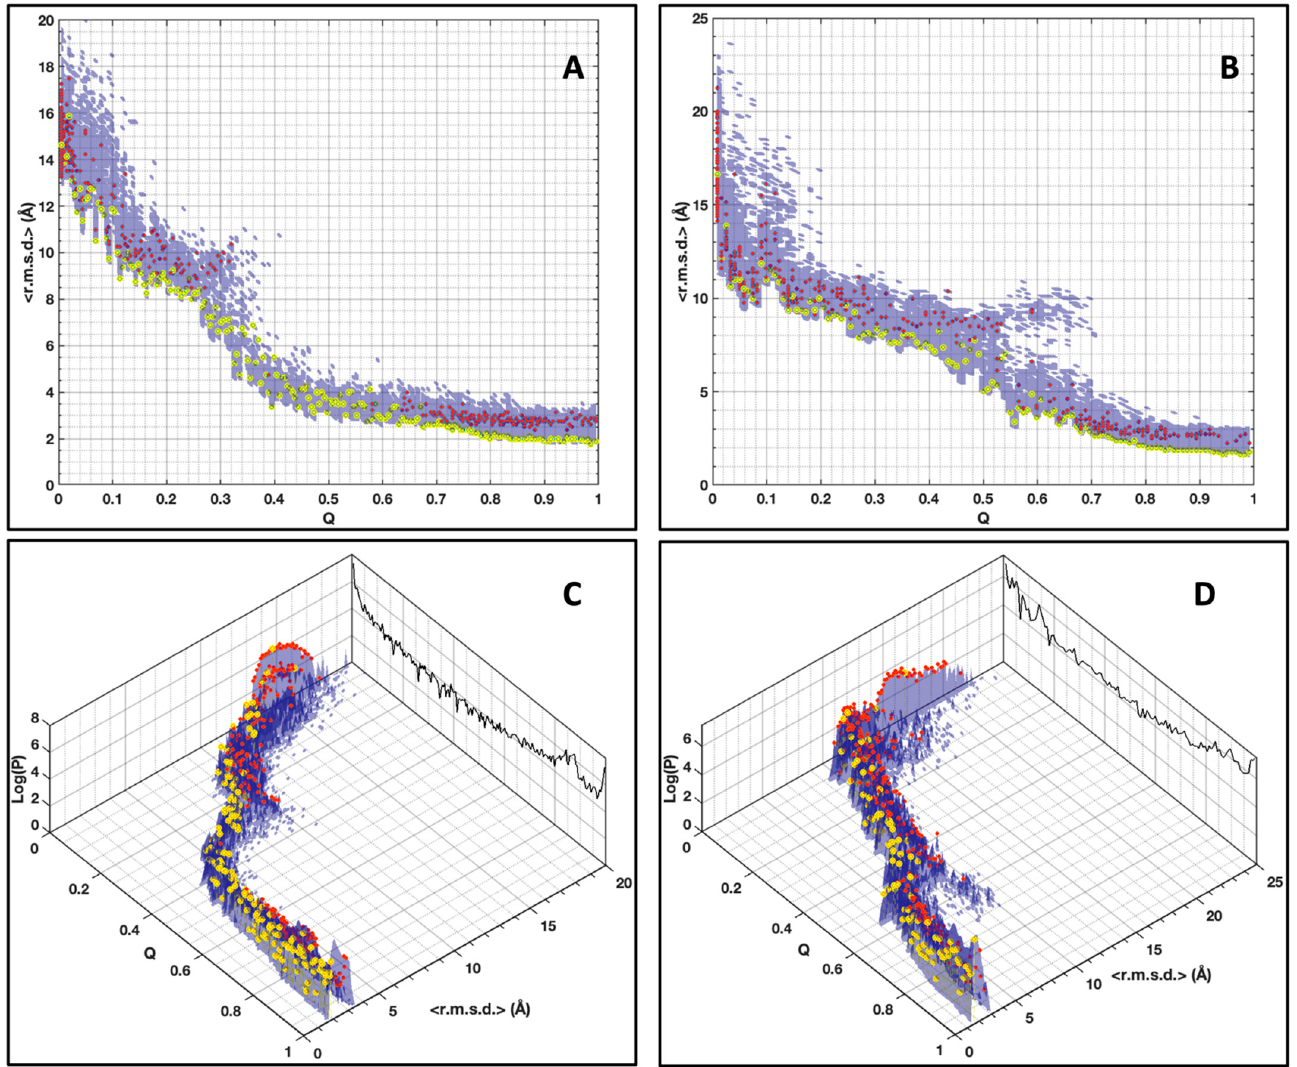
Figure 5. Distribution of the conformers’ population (Log scale) in relation to their <r.m.s.d.> (bin size 0.125 Å) and their native constraints fraction (Q) for AVR-Pia ( A , C ) and AVR-Pib ( B , D ). Cluster centroids are indicated by the red dots. The centroids for the most populated clusters are indicated by the yellow dots. The total conformer populations (Log scale) vs. Q are projected on the back-planes (black color) in panels C , D .